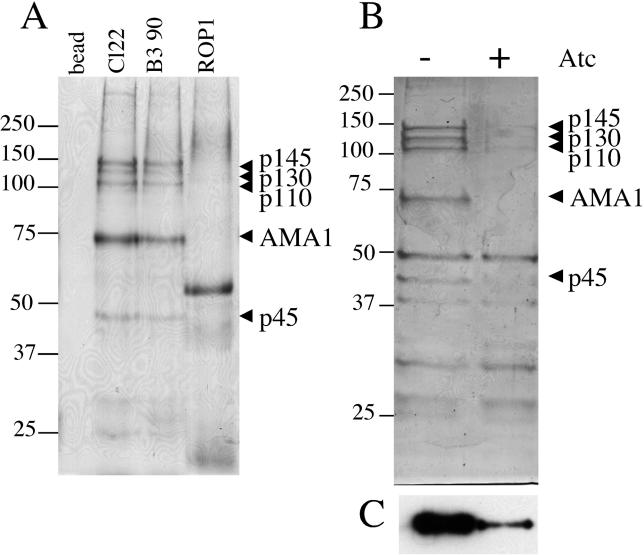
Identification of TgAMA1-Associating Proteins(A) Monoclonal antibodies CL22 and B3.90 were used to immunoprecipitate TgAMA1 and associating proteins from RIPA lysates of wild-type tachyzoites. The resulting material was resolved by SDS-PAGE followed by Coomassie staining to detect the proteins. Controls were immunoprecipitation with beads alone or an irrelevant mAb specific for the rhoptry bulb protein, ROP1. Each lane represents the product of 107 parasites. The polypeptides specifically associating with TgAMA1 are denoted on the right by their estimated molecular masses in kDa: p145, p130, p110, and p45. Molecular mass markers (in kDa) are indicated on the left of each panel.(B) mAb CL22 was used to immunoprecipitate TgAMA1 and associating proteins from ΔAMA/AMA1-myc parasites without (−) or with (+)Atc.(C) Immunoblot of the lanes shown in Figure 1B probed with antibody specific for TgAMA1.